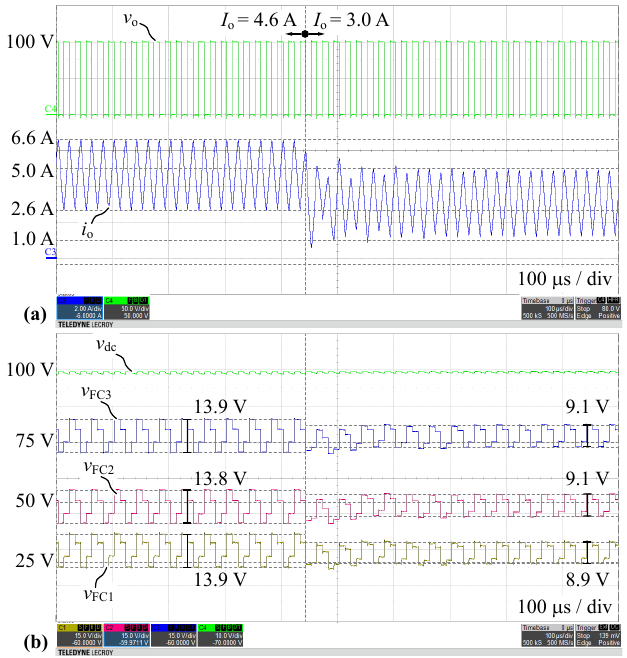
Figure 15. Measured waveforms for Q2L-5L-FCC in configuration 2 (cid:13) with OL balancing during a negative load step from 100% to 67% of the nominal load ( I o = 4.6A → 3.0A, ∆ I pp = 4A): ( a ) Output voltage v o and current i o , ( b ) DC-link capacitor voltage ( v dc ) and FC voltages v FC{1,2,3} . A delay time T delay = 100ns is